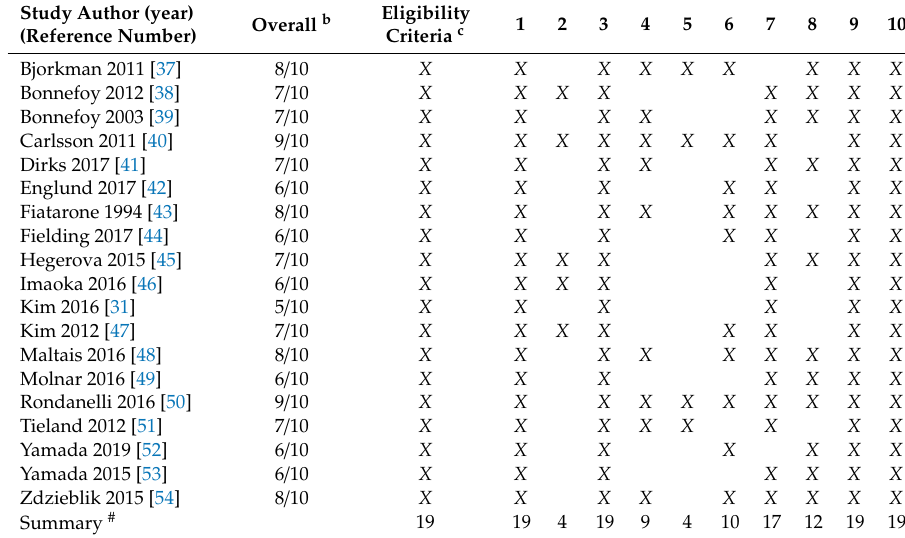
Table 2. Summary of methodological quality based on the PEDro classification scale a